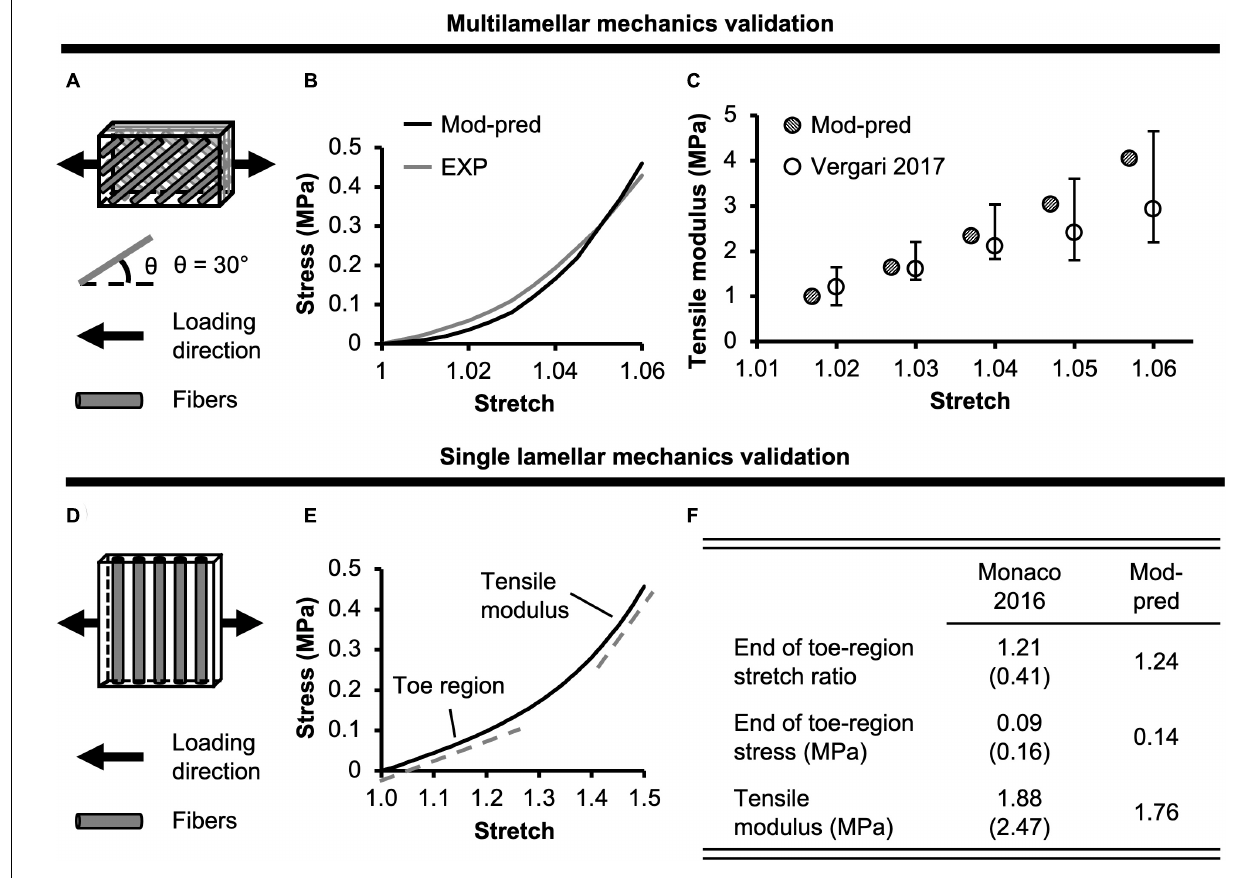
FIGURE 2 | (A) Model validation schematic for multilamellar mechanics of bovine annulus fibrosus (AF). Model geometry and loading conditions were determined based on protocols reported in Vergari et al. (2017). (B) Model-predicted (Mod-pred) bovine AF multilamellar stress-stretch response compared to representative experimental (EXP) data from Vergari et al. (2017). (C) Model-predicted tensile modulus at five specified stretch ratios compared to experimental data from Vergari et al. (2017). (D) Model validation for single lamellar mechanics of bovine AF. Model geometry and loading conditions were determined based on protocols reported in Monaco et al. (2016). (E) Model-predicted bovine single lamellar stress-stretch response. (F) Model-predicted bovine AF single lamellar tensile mechanical properties compared to experimental data [mean (standard deviation)] from Monaco et al.